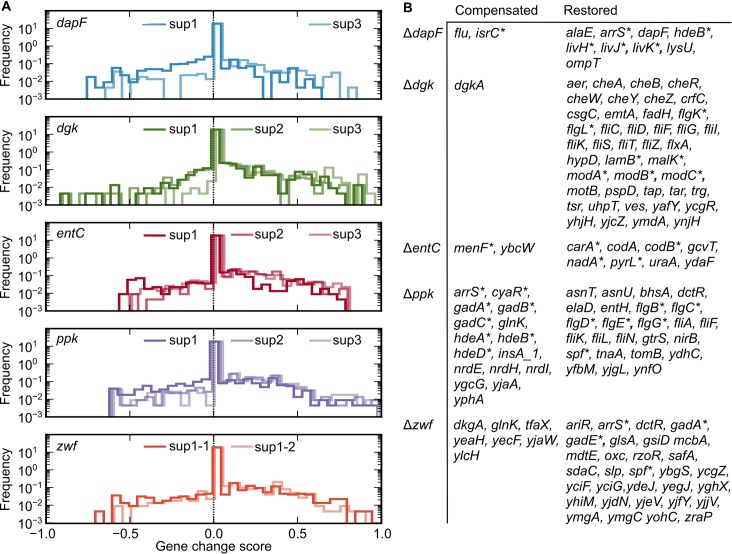
Evaluation of the compensatory and restorative responses to each gene deletion.(A) Histogram of the Gene Change Score (GCS) exhibiting compensatory (negative) and restorative (positive) transcriptional changes for each sup strain (marked by different lines). Each case clearly shows a bias toward positive (restorative) changes. (B) List of genes exhibiting the strongest responses (GCS > 0.4 or < –0.2) across all sup strains associated with each deletion strain. Genes marked by an asterisk are discussed in more detail in the text.